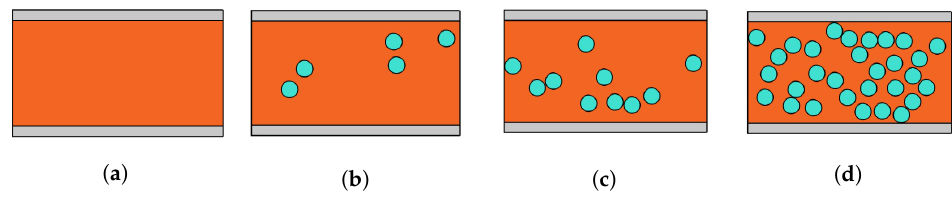
Figure 1. 2D simulation model design with BST (orange) between two silver electrodes (gray) with randomly placed LDK inclusions (blue): ( a ) without the inclusions and ( b – d ) with 5%, 10%, 30% LDK inclusions in the BST region. The BST is 2 × 1 mm 2 in dimensions and each inclusion is 0.16 mm in